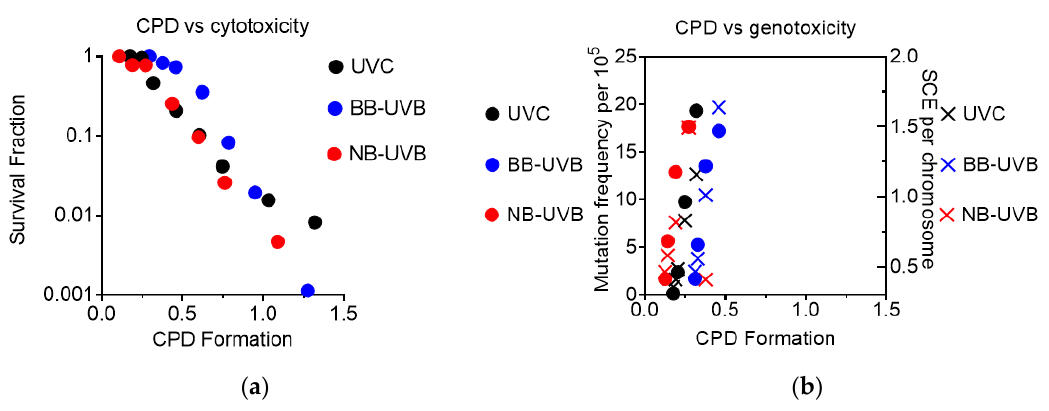
Figure 7. Summary of CPD formation vs. cytotoxicity and genotoxicity. ( a ) CPD formation vs. cytotoxicity; ( b ) CPD formation vs. genotoxicity.